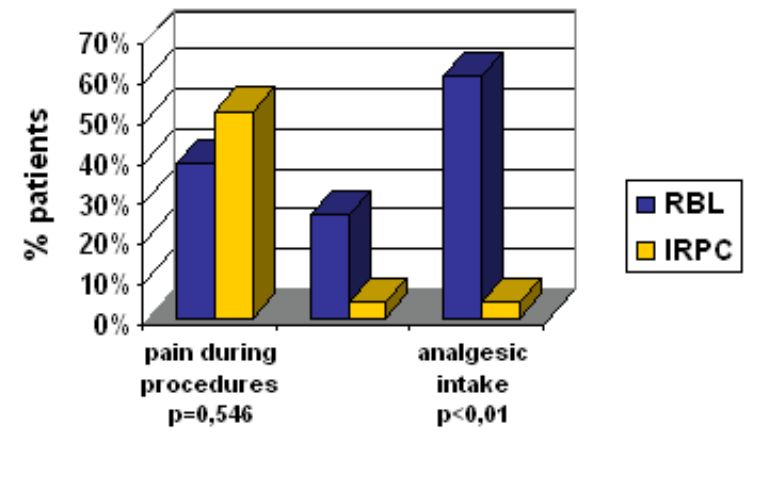
FIGURE 1 – Pain during and after procedures (percentages)